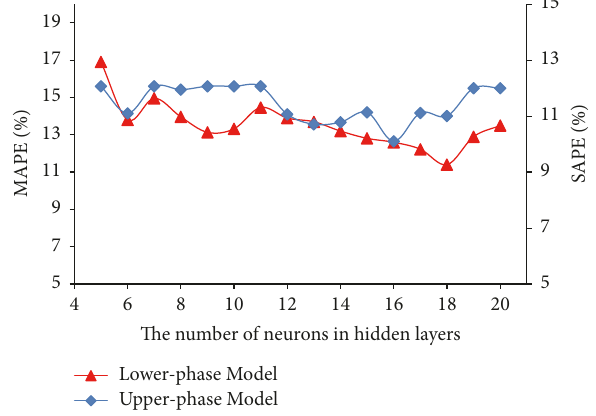
Figure 8: Relationship between MAPE/SAPE and the number of neurons on weekend.